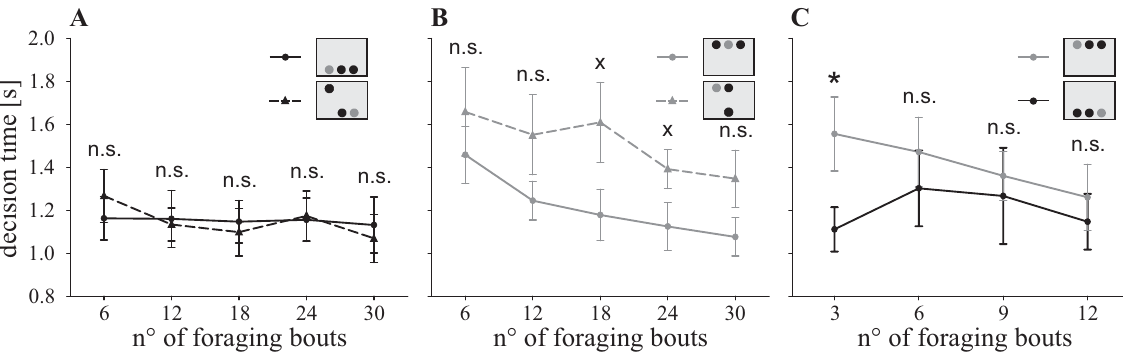
Figure 4. Decision time of honeybees depending on treatments. Decision time of the three experimental groups: ‘ventral group’ (black straight line, black circle), ‘dorsal group’ (grey straight line, grey circle) and ‘mixed group’ (ventral half: black dashed line, black triangle; dorsal half: grey dashed line, grey triangle). A . When searching for the target in the ventral half of the visual field, the bees of the ‘mixed group’ made their decision at a similar speed as the ‘ventral group’ ( χ 2 =0.00, P=0.979). They did not improve their performance ( χ 2 =2.25, (1) (4) P=0.689). B . Comparing the ‘dorsal group’ with the dorsal bouts of the ‘mixed group’, the bees showed no significant difference in their decision time ( χ